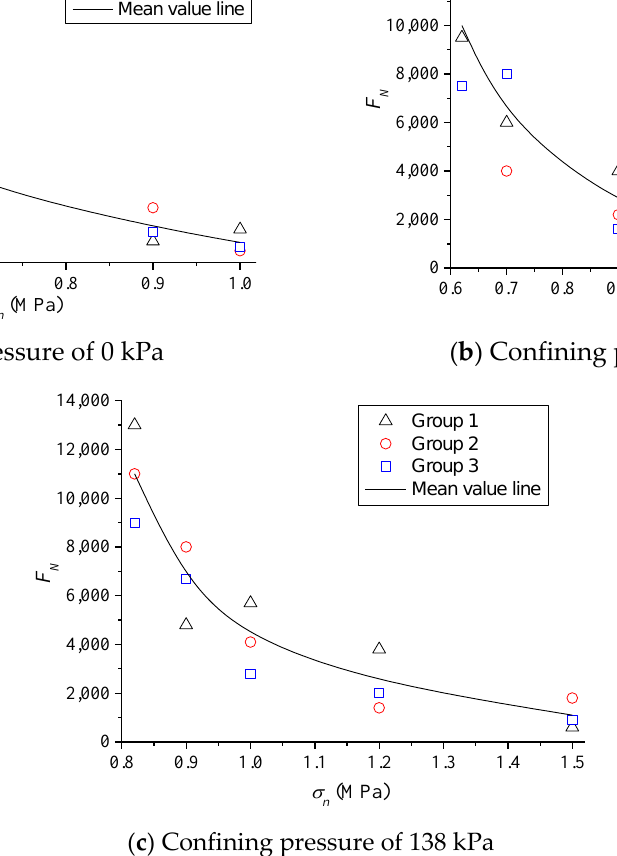
Figure 10. F N under different pressure stress level and confining pressure ( a – c ) at 60 °C.